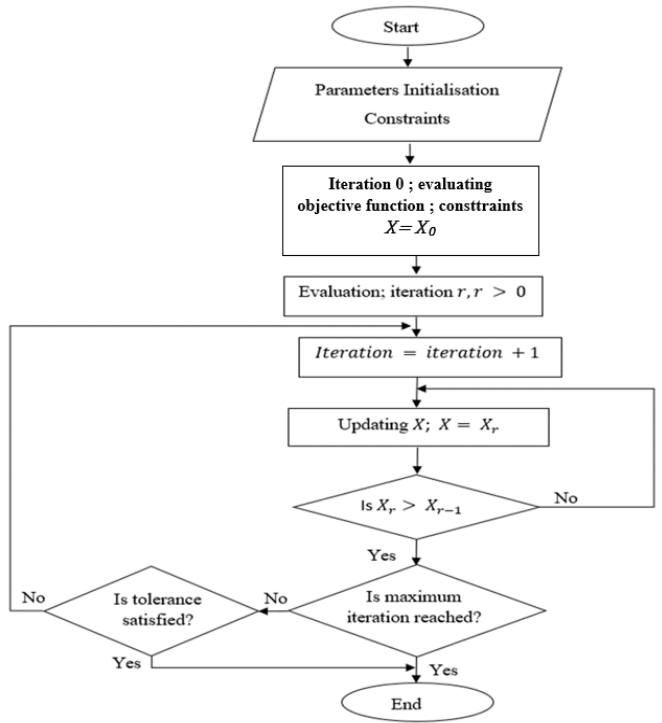
Figure 2. Flowchart of the Fmincon optimisation algorithm.